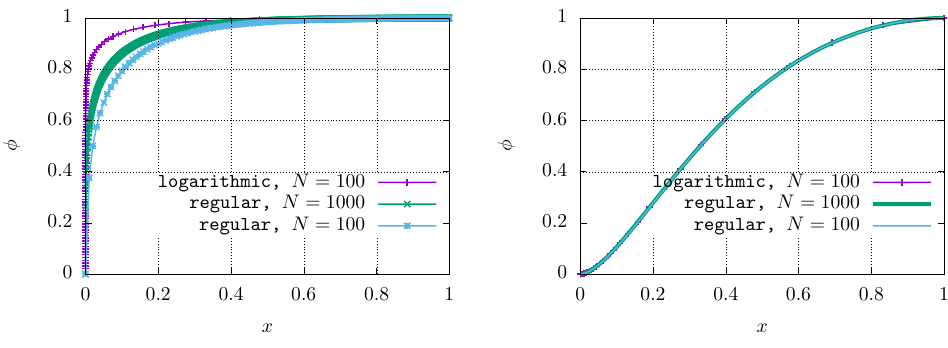
Figure 3. Mesh convergence for α = β = 0.0 ( left plot ) and α = 0.1, β = 0.01 ( right plot